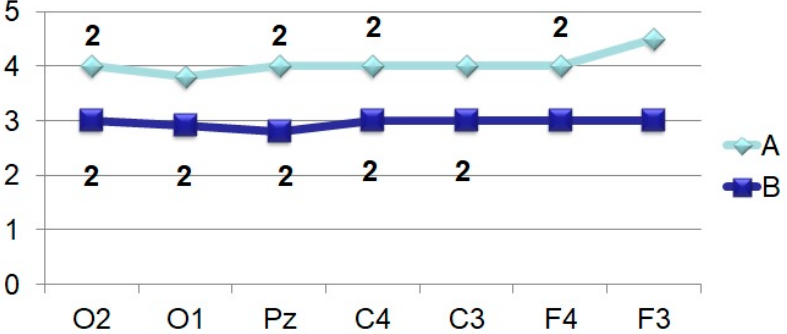
Figure 8. Averaged values of amplitudes and factor characteristics of amplitudes and PL of the N 750 ERP component. Note. Legend in Figure 3.